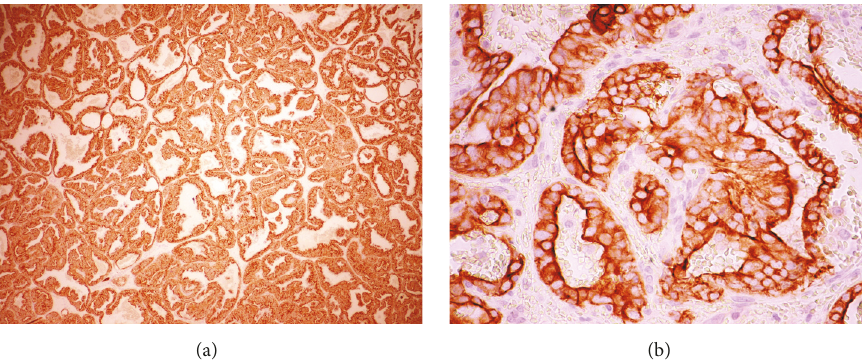
Figure 3: Dermal infiltrate positive for prostate specific antigen (PSA). This marker is usually positive in prostatic carcinoma (avidin-biotin- peroxidase complex staining. Original magnifications: 100x (a), and 400x